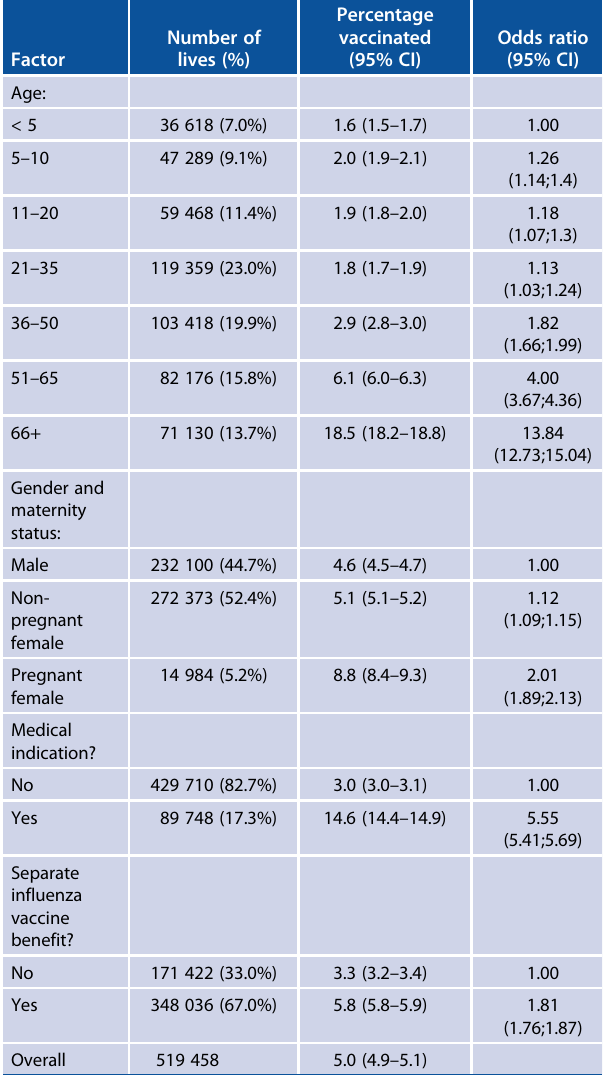
Table 2: Percentage of medical scheme members vaccinated by analytic group in 2015